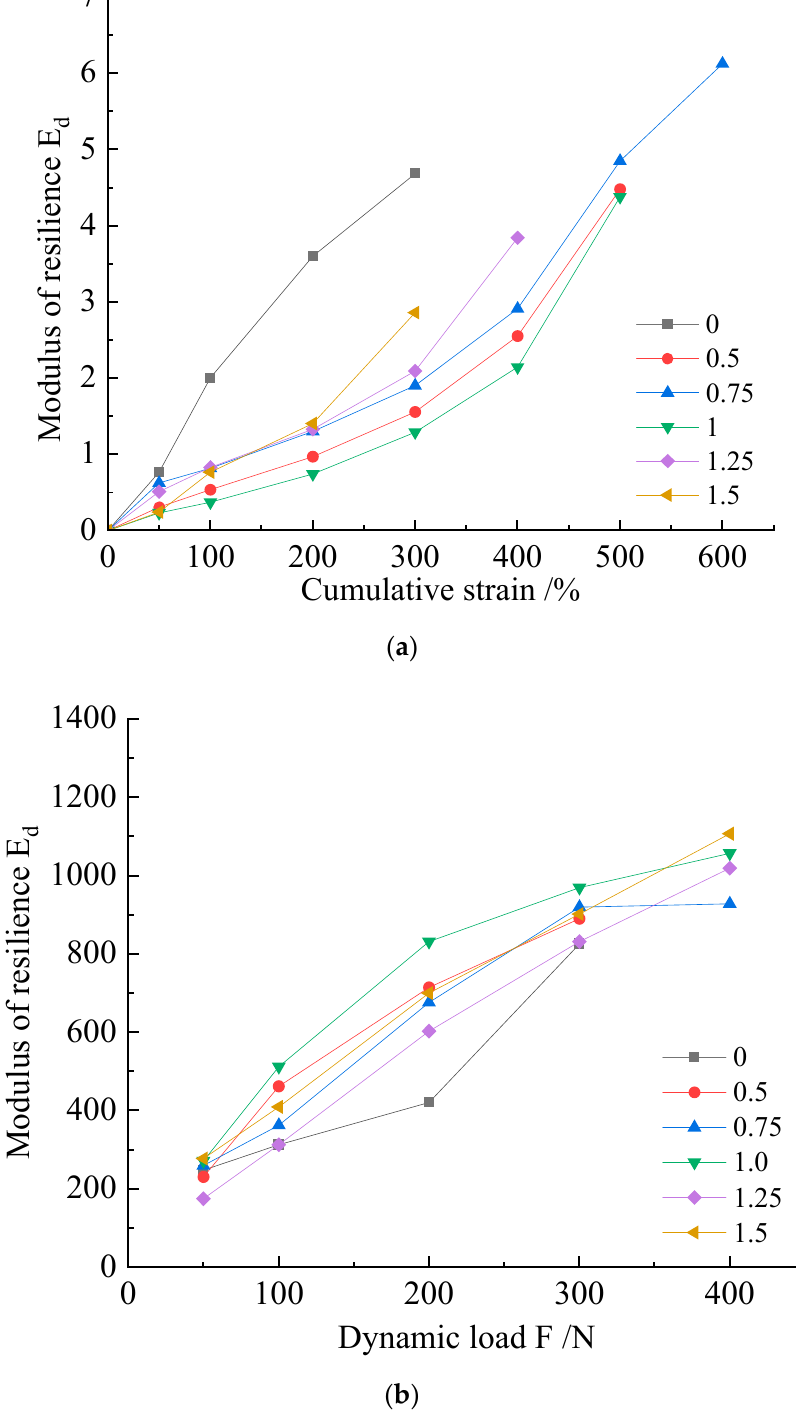
Figure 7. ( a ) Cumulative strain–resilience modulus (Ed) curves and ( b ) dynamic load–resilience modulus curves of M scheme samples.